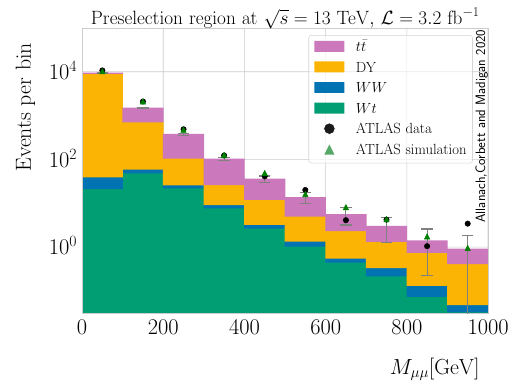
Table 5 Phase space cuts applied at parton-level in Madgraph5 to Fig. 8 Validationplotshowingoursimulationsofthe M μμ distribution efficiently simulate events in the signal region for the 13 TeV LHC and of the SM backgrounds in the search for the pair production of second √ future colliders. Cuts on p T and M μμ are in units of GeV s = 13 TeV, L = 3 . 2 fb − 1 generation LQs in the μμ jj channel at in the preselection region. We compare our simulations to the ATLAS Collider simulations and data for validation